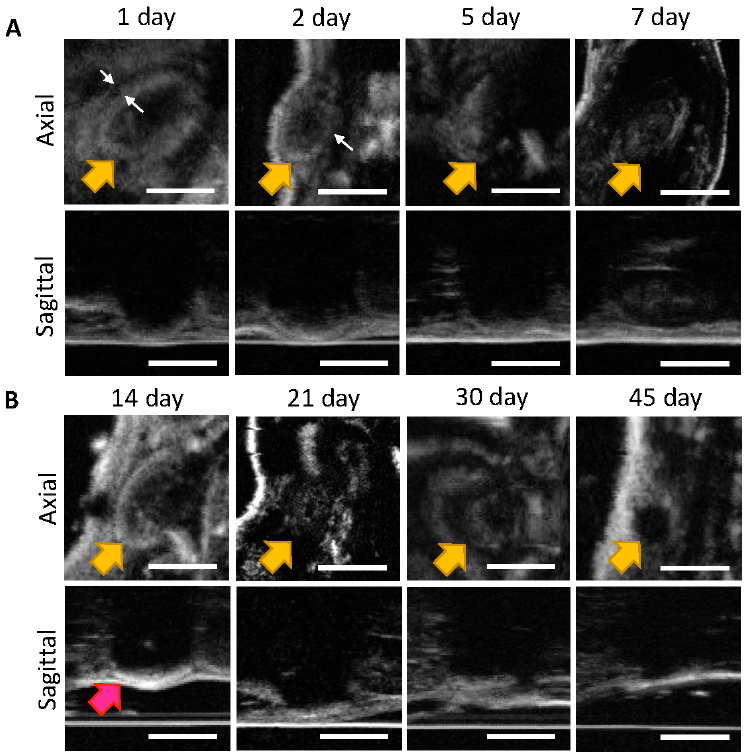
Figure 2. Representative B mode ultrasound images of axial and sagittal views of 80 μ L placebo ISFI (1:2 w / w PLGA/NMP) ISFIs injected into female NSG mice ( n = 8) taken over 45 days: ( A ) Days 1–7 ( B ) Days 14–45. Yellow arrows indicate location of the ISFI, white arrows indicate precipitation of PLGA, and pink arrows represent ISFI flattening. Scale bar = 5 mm.